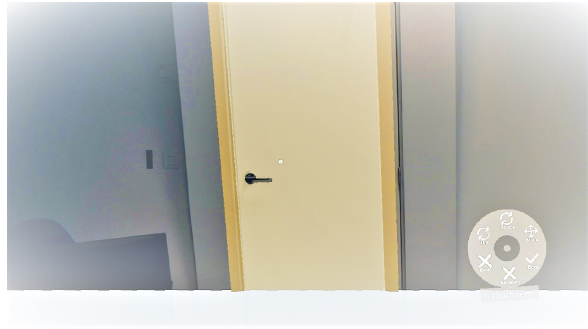
Figure 4. Matching the door’s position/rotation to the real